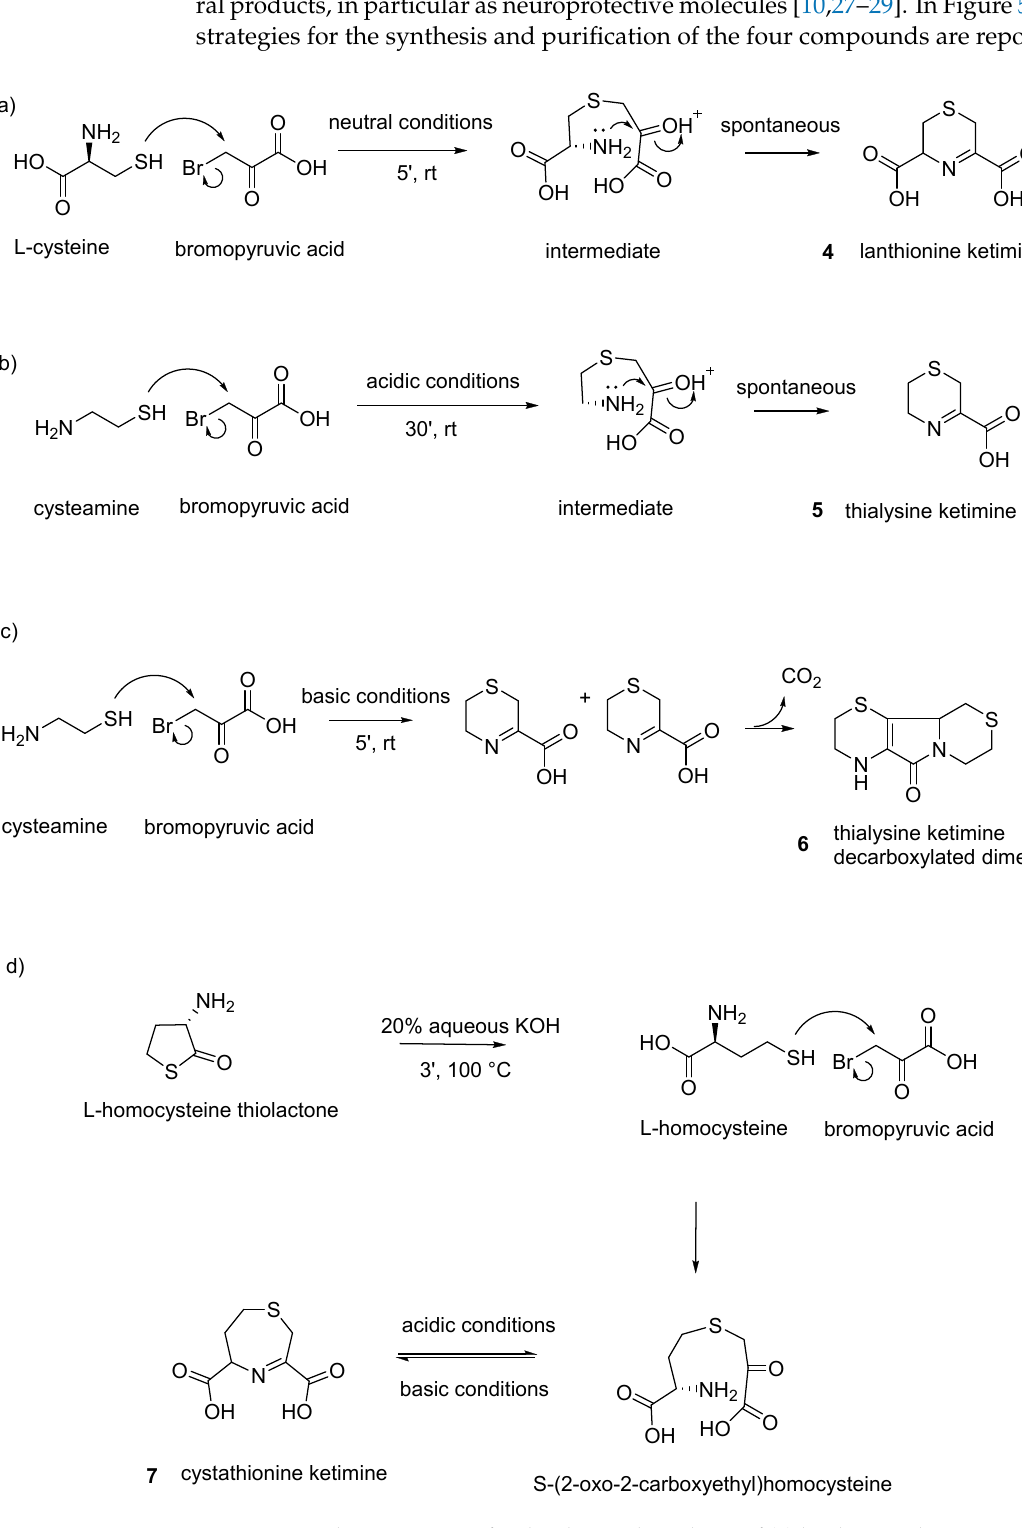
Figure 5. Synthetic strategies for the chemical synthesis of ( a ) lanthionine ketimine LK, ( b ) thialysine ketimine TK, ( c ) thialysine ketimine decarboxylated dimer TK-DD and ( d ) cystathionine ketimine CK.